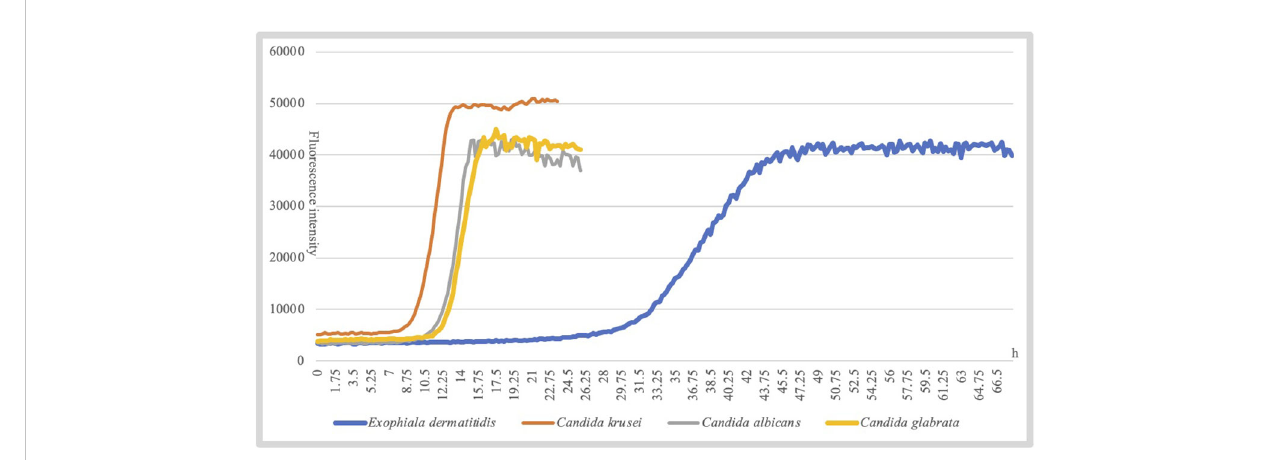
FIGURE 3 Different species of fungi slightly have different growth